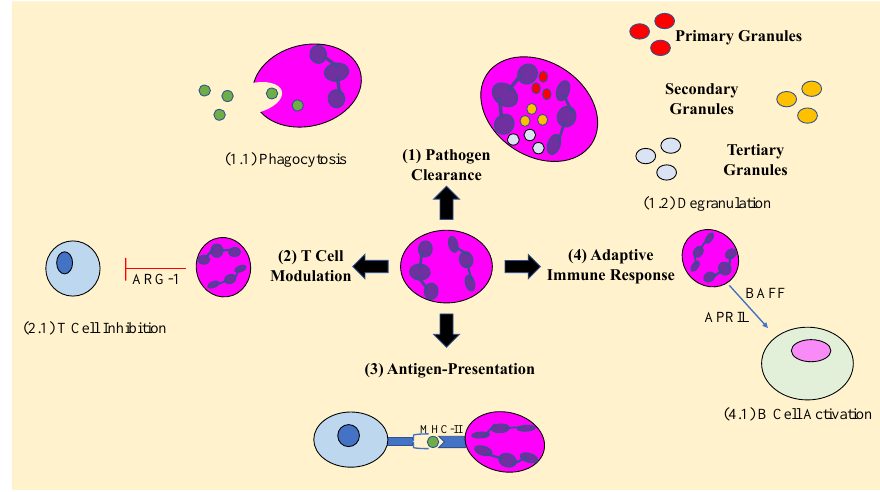
Figure 1. Neutrophil-mediated roles during an immune response. Arginase 1 (ARG-1), major histocompatibility complex II (MHC-II), B-cell activating factor (BAFF), A Proliferation-Inducing TNF Ligabd (APRIL).